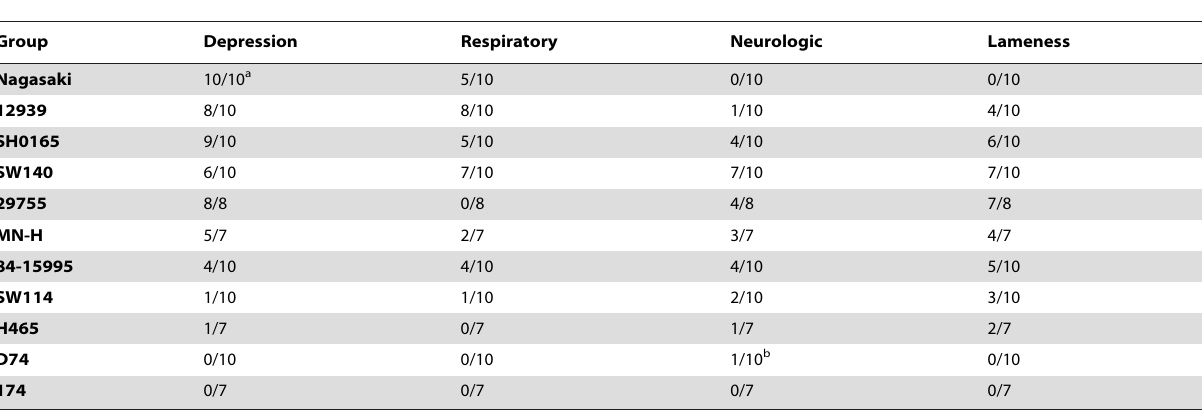
Table 5. Frequency of clinical signs in H. parasuis infected pigs.